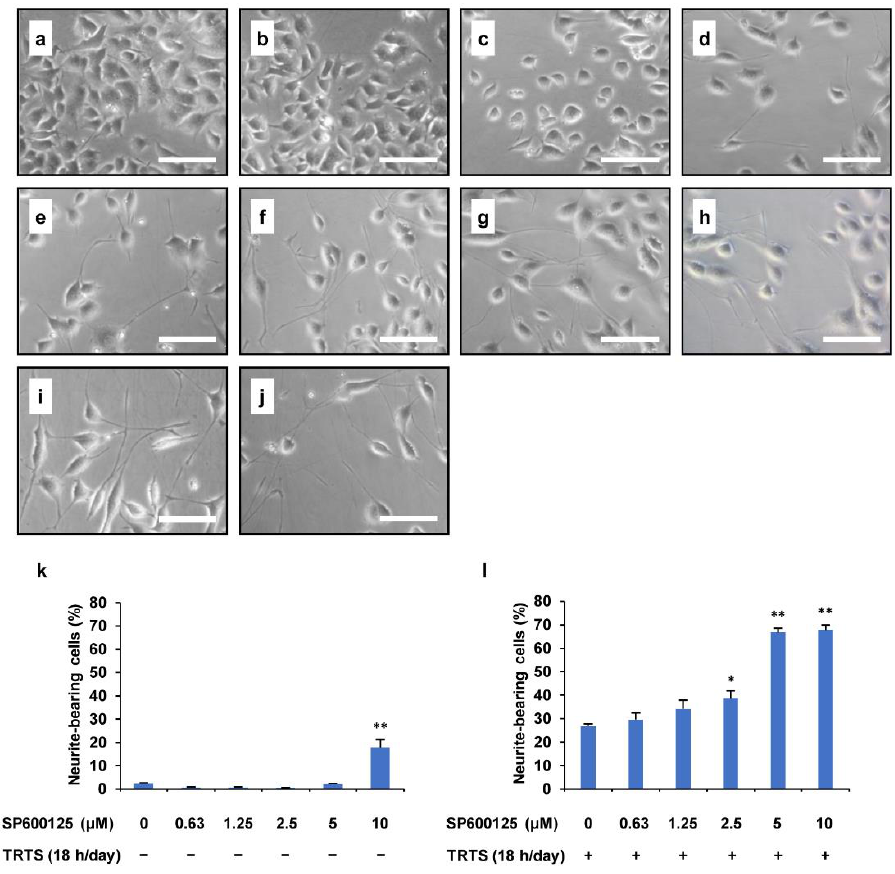
Figure 4. Dose-dependent SP600125-mediated enhancement of TRTS-induced neuritogenesis in PC12-P1F1 cells. PC12-P1F1 cells were pretreated with SP600125 (0 –10 μM) with or without TRTS (18 h/day for 7 days). ( a – d ) Representative phase-contrast images of PC12-P1F1 cells treated with the indicated concentrations of SP600125 in the absence of TRTS: 0 μM ( a ), 2.5 μM ( b ), 5 μM ( c ), and 10 μM ( d ). ( e – j ) Representative phase-contrast images of PC12-P1F1 cells on day 7 incubated with the indicated concentrations of SP600125 in the presence of TRTS: 0 μM ( e ), 0.625 μM ( f ), 1.25 μM ( g ), 2.5 μM ( h ), 5 μM ( i ), and 10 μM ( j ). Scale bars: 100 μm. ( k , l ) PC12-P1F1 cells were scored for neurite outgrowth after 7 days of incubation. The data represent the means ± standard deviation of three replicates. * p < 0.05 vs. control; ** p < 0.01 vs. control ( k ), or TRTS alone ( l ).